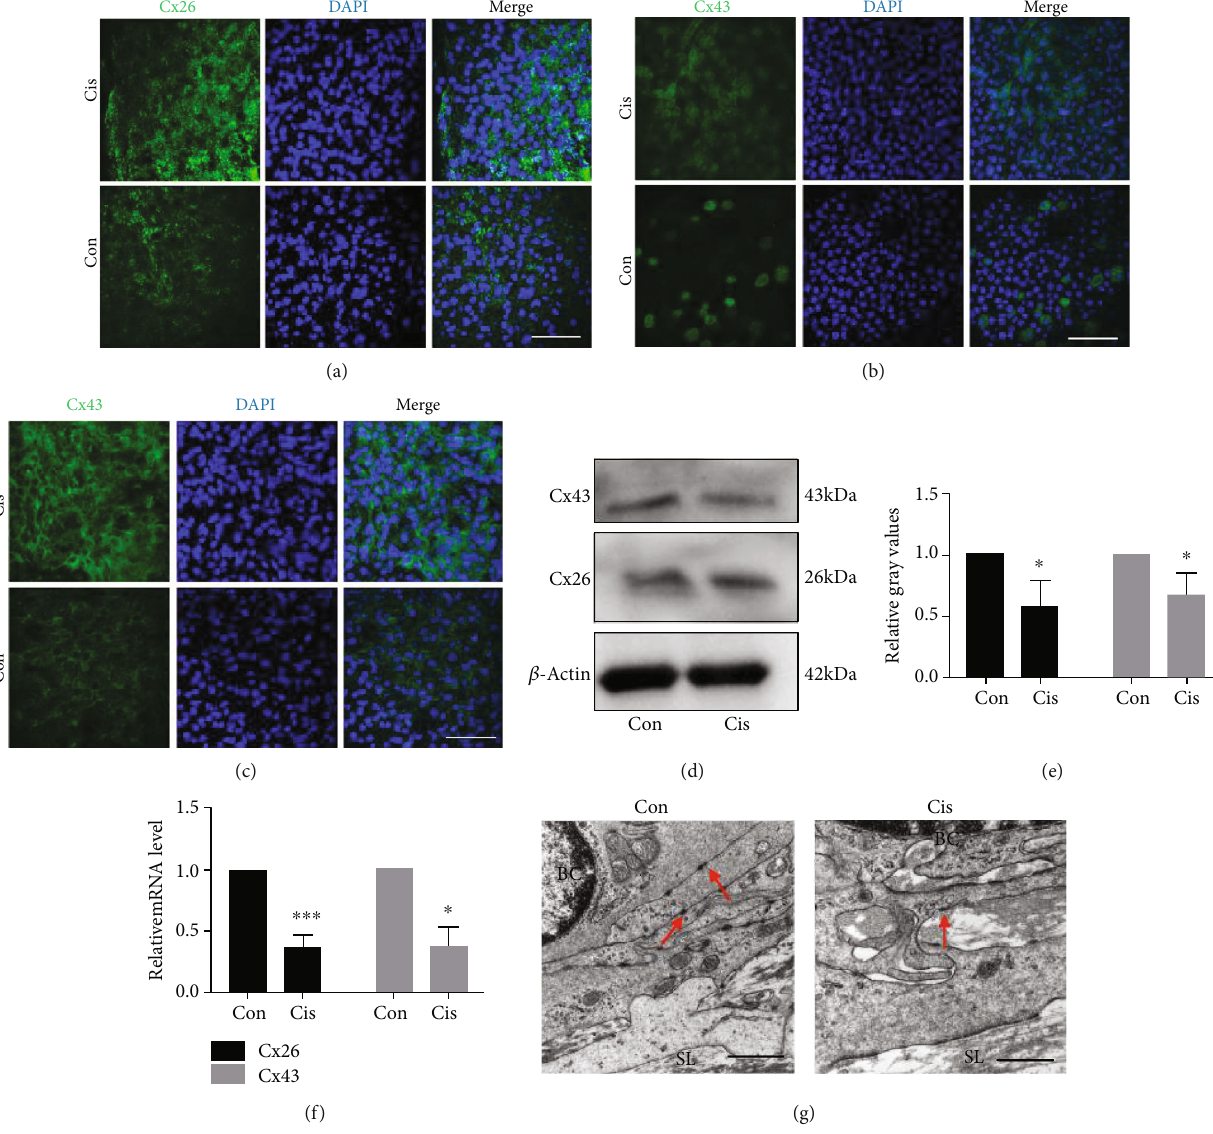
Figure 4: Cisplatin reduces expressions of Cx26 and Cx43 in SV. (a) The distribution of Cx26 (green) in BCs by immuno fl uorescence staining. The moderate-to-strong Cx26 signal is visible in the cell cytoplasm of BCs in the control, while the weak-to-moderate Cx26 signal is seen in cisplatin-treated mice. Nuclei were stained with DAPI (blue). Scale bars, 100 μ m. (b, c). The distribution of Cx43 (green) in the MCs (b) and BCs (c) by immuno fl uorescence staining. After the treatment of cisplatin, the weak-to-moderate Cx43 signal was found in the SV. A strong signal for Cx43 was found in some MCs in cisplatin-treated mice. Nuclei were stained with DAPI (blue). Scale bars, 100 μ m. (d) Western blot analysis of the cell lysates of SV treated with cisplatin. β -Actin was used as a loading control. (e) Densitometric quanti fi cation of the mean (SD) ratio of Cx43 and Cx26 expressed as mean ± SD ( n = 3 ). (f) qRT-PCR shows mRNA for Cx43 and Cx26 in the SV ( n = 3 ). (g) The ultrastructure of SV analyzed by TEM. The number of anchoring connections at the basal layer is reduced in cisplatin-treated mice. Arrows point to anchoring connections. Scale bars, 10 μ m. BC: basal cells; SL: spiral ligament; Con: 0.9% physiological saline; Cis: cisplatin. ∗ p < 0 : 05 , ∗∗ p < 0 : 01 , and ∗∗∗ p < 0 : 001